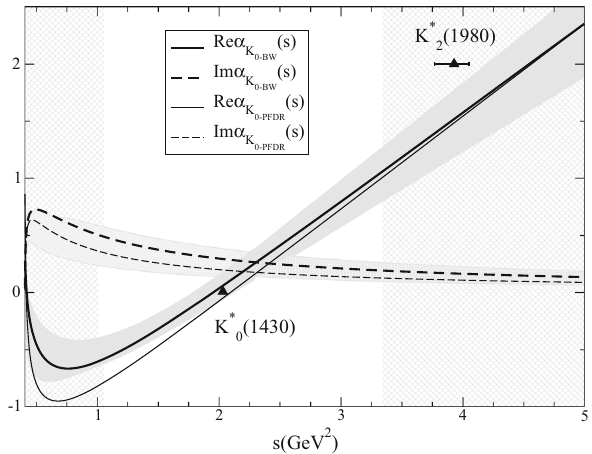
( 1430 ) Fig. 2 Real ( solid ) and imaginary ( dashed ) parts of the K ∗ 0 Regge trajectory. The gray bands cover the uncertainties due to the errors in the input pole parameters for the Breit–Wigner pole, which central values are the thick lines , the values obtained for the PFDR-pole are the thin lines . The area covered with a mesh is the mass region starting three half-widths above and below the resonance mass, where ( 1430 ) does our approximation that K π is elastic and dominated by K ∗ 0 not longer hold and where our approach should be considered only as a ( 1980 ) resonance listed in the RPP mere extrapolation. We show the K ∗ 0 ( 1430 ) partner in this that seems a good candidates for a K ∗ 0